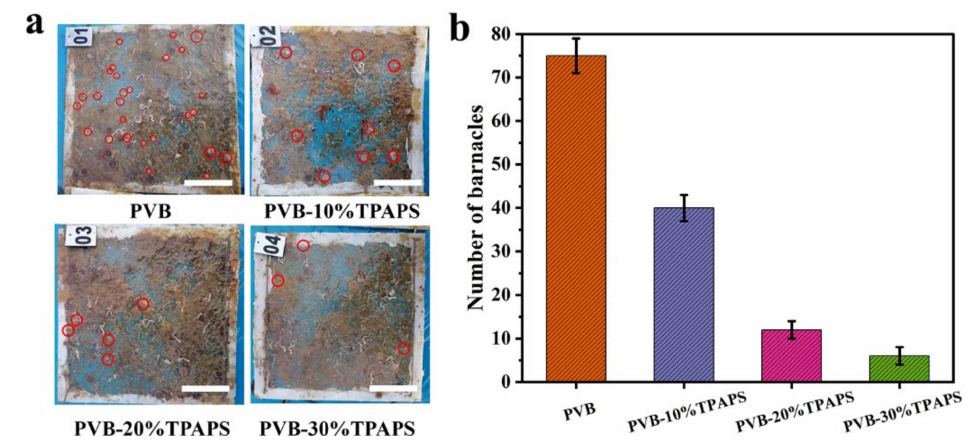
Figure 10. Antifouling test of PVB-X%TPAPS, measuring barnacle settlement under the marine field. ( a ) Photographs of the actual marine antifouling performance (without cleaning), partially apparent barnacles were marked with red circles in the graphs. ( b ) A chart showing the number of adhered barnacles. The plate size was 15 cm × 15 cm × 5 mm in this